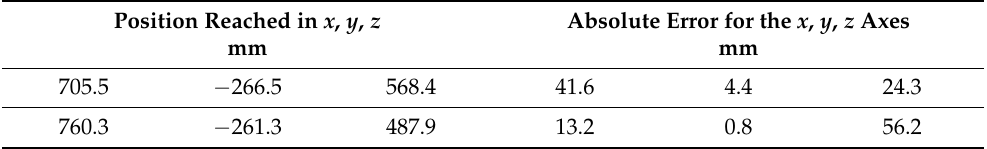
Table 6. Measurement of the position when switching the switch in the case of covering the markers during the work. The reference position is 747.1, − 262.1, 544.1